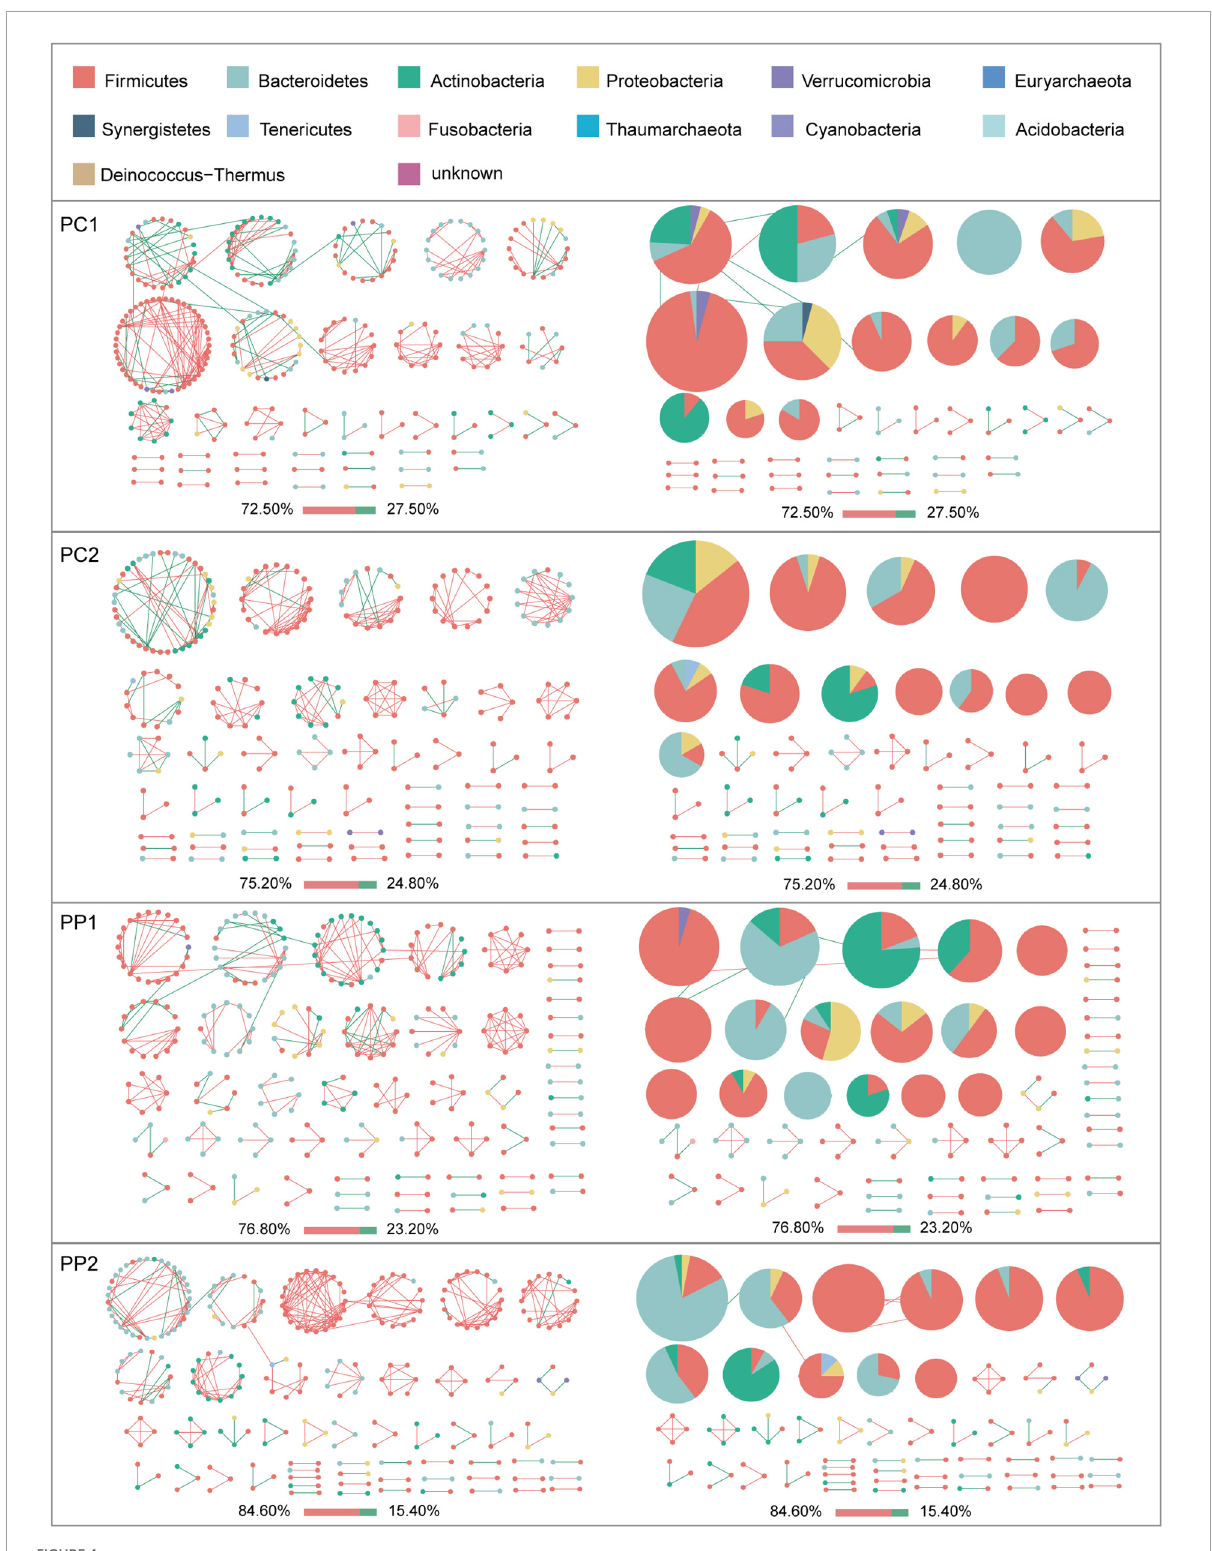
FIGURE4 Modules within gut microbial networks of pregnant women with or without probiotic supplementation. The colors of nodes represent different major phyla; pie charts exhibit the phylum level composition of modules with ≥ 5 nodes. Red edges indicate positive correlations between nodes, whereas green edges indicate negative correlations. The bar underneath each networks demonstrate the proportion of positive and negative